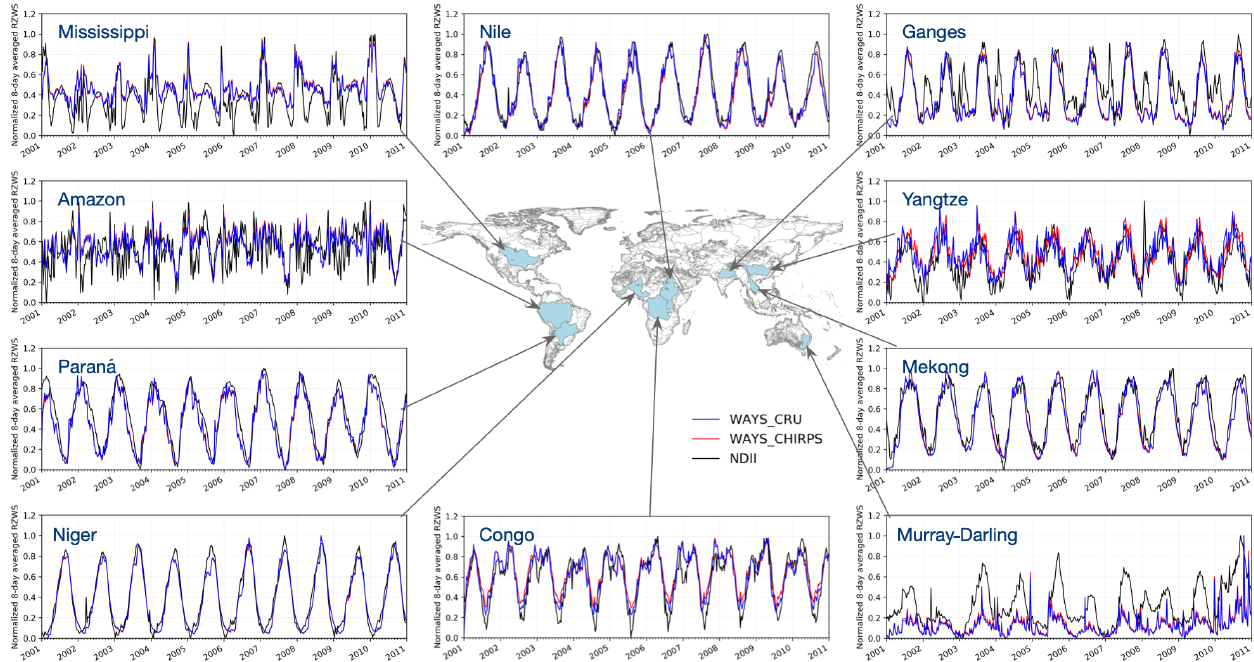
Figure 5. Time series of 8-day normalized RZWS simulated by the WAYS model and NDII value.